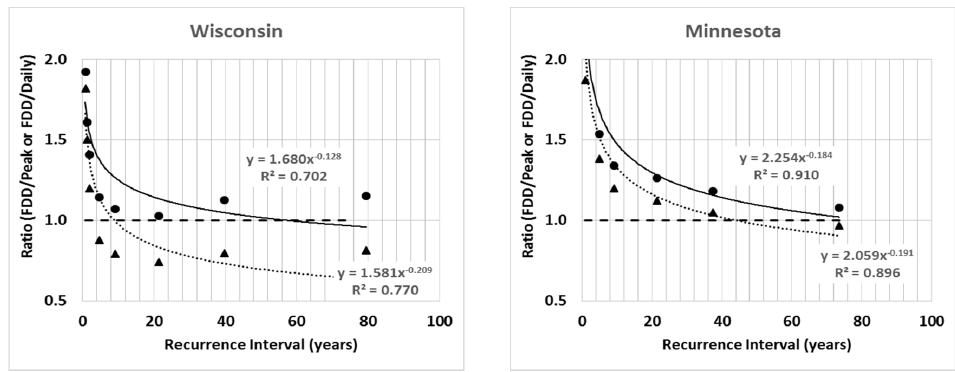
Figure 5. For different recurrence intervals, the ratio of calculated full daily distribution (FDD) discharges to the Log-Pearson Type 3 results for an annual series of instantaneous peaks (solid circles) and peak daily means (solid triangles). The values are based on data from Table 6. The solid and dotted lines are regressions lines associated with the solid circles and solid triangles, respectively.